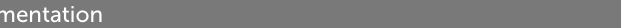
TABLE 4 Administering CBT for youth anxiety through online computer